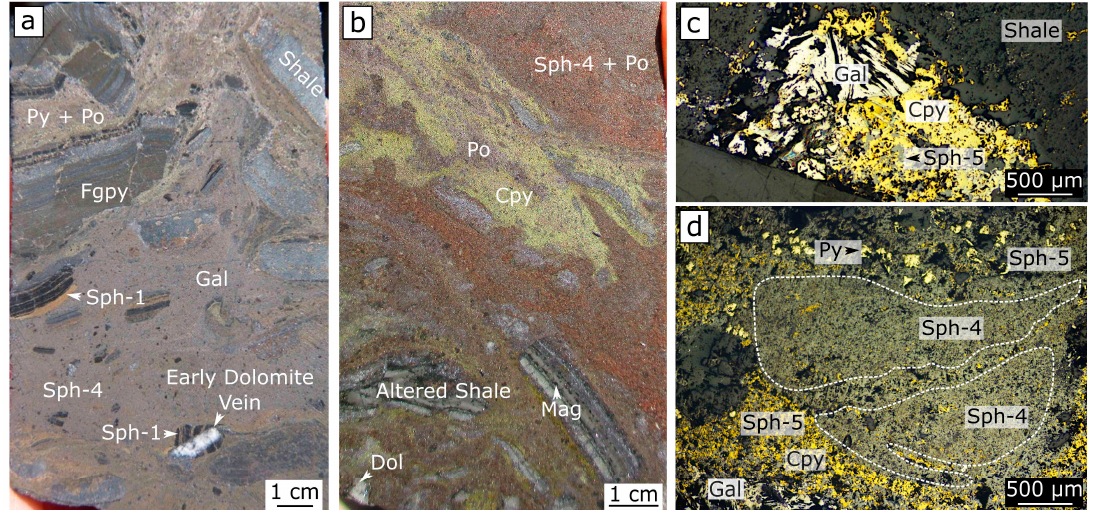
Figure 5. Sphalerite paragenesis at the Hilton Zn-Pb (Ag) deposit (continued). ( a ) Polymetallic sulphide-rich breccia containing sph-4, abundant pyrrhotite and high grade Pb mineralisation. Note the presence of early stratabound Zn mineralisation and early dolomite veins within the clasts of shale. ( b ) Polymetallic breccia containing abundant pyrrhotite and chalcopyrite that overprints sph-4. ( c , d ) Reflected light photomicrographs highlighting the relationship between high-grade Cu mineralisation and sph-5. Note the recrystallisation of sph-4 to form sph-5 in Figure 5d. Abbreviations: sph = sphalerite, dol = dolomite, fgpy = fine-grained pyrite, py = pyrite, gal = galena, po = pyrrhotite, cpy = chalcopyrite, mag = magnetite.